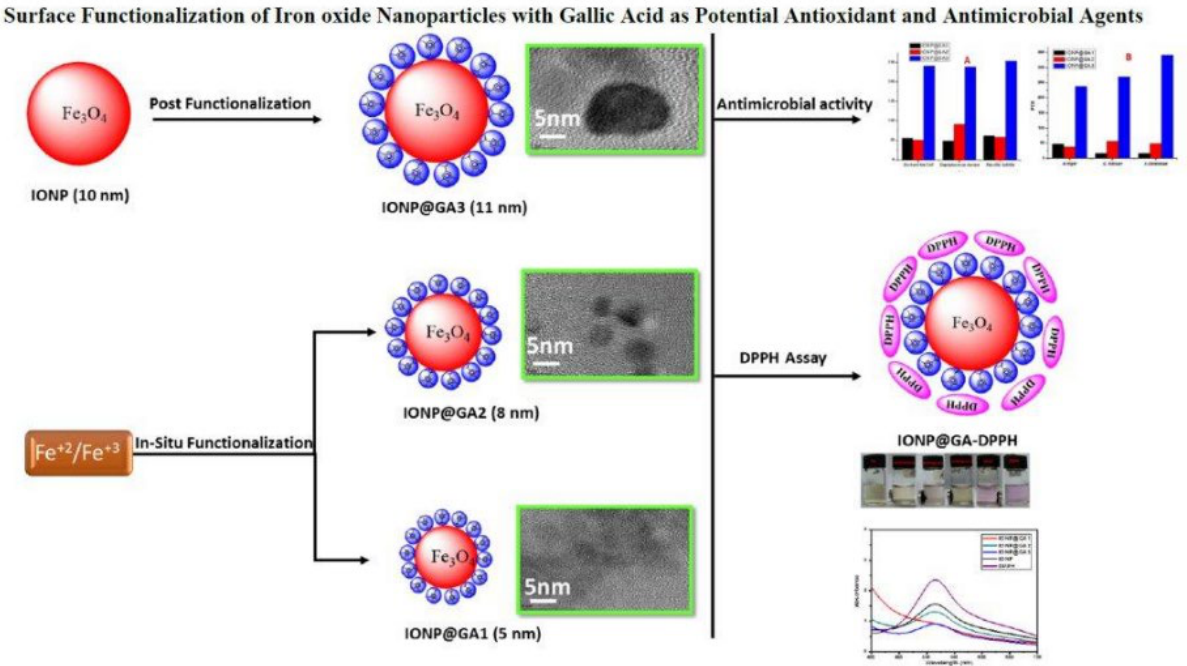
Figure 11. Surface Functionalization of IONP with Gallic Acid.